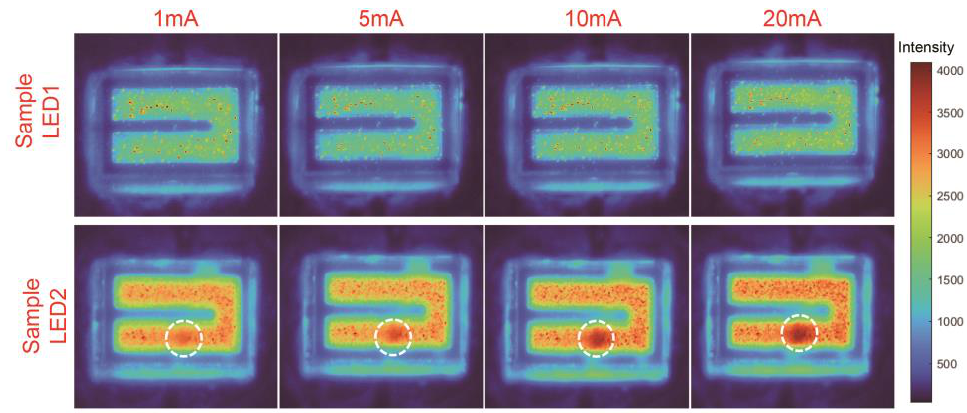
Figure 7. The two LED chips were tested for microscopic light distribution at 1 mA, 5 mA, 10 mA, and 20 mA.